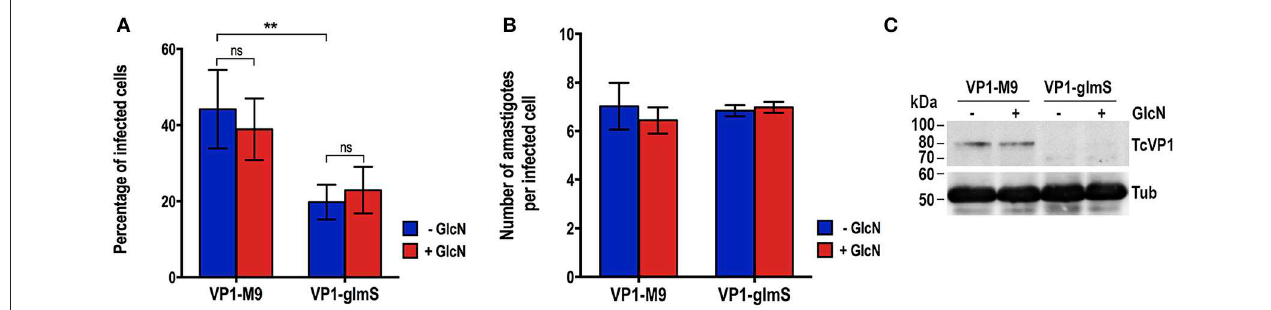
FIGURE 5 | Invasion and intracellular replication of TcVP1-M9 and TcVP1-glmS cell lines. (A) TcVP1-M9 and TcVP1-glmS trypomastigote infection of Vero cells. There was a significant difference in the percentage of infected Vero cells but not in the number of intracellular amastigotes per infected host cell observed 48h post infection (B) . Values are mean ± s.d.; n = 3; ** p < 0.01; ns , not significant (Two-way ANOVA with multiple comparisons test). (C) Western-blot analysis of TcVP1-M9 and TcVP1-glmS trypomastigotes. Anti TcVP1 antibody labels an expected band of 85 kDa in TcVP1-3xHA - M9 - but not in TcVP1-3xHA - glmS - epimastigotes.